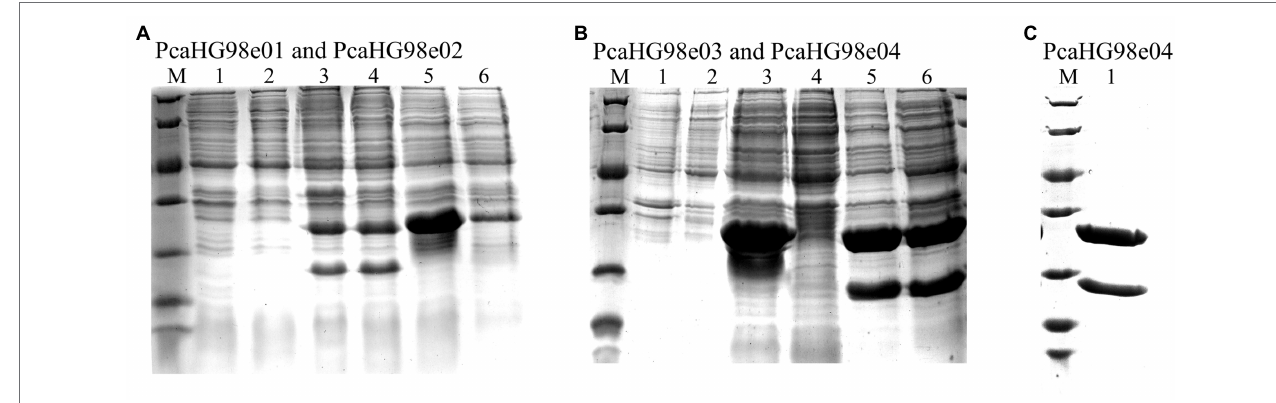
FIGURE 2 | Determination of the expression of recombinant PcaHG in E . coli BL21 (DE3) by SDS-PAGE. Total cell extract and soluble cell extract from induced E . coli BL21 (DE3). Lane M, protein molecular mass standards (Unstained Protein Molecular Weight Marker, No. 26610, Thermo Fisher Scientific, Waltham, MA, United States). (A) lane 1, total BL21 (DE3)/pET-28a (+), lane 2, soluble BL21 (DE3)/pET-28a (+), lane 3, total BL21 (DE3)/pET-28a- pcaHG98e01 , lane 4, soluble BL21 (DE3)/pET-28a- pcaHG98e01 , lane 5, total BL21 (DE3)/pET-28a- pcaHG98e02 , lane 6, soluble BL21 (DE3)/pET-28a- pcaHG98e02 . (B) lane 1, total BL21 (DE3)/pET-28a (+), lane 2, soluble BL21 (DE3)/pET-28a (+), lane 3, total BL21 (DE3)/pET-28a - pcaHG98e03 , lane 4, soluble BL21 (DE3)/pET-28a- pcaHG98e03 , lane 5, total BL21 (DE3)/pET-28a- pcaHG98e04 , lane 6, soluble BL21 (DE3)/pET-28a- pcaHG98e04 . (C) lane 1, soluble BL21 (DE3)/pET-28a- pcaHG98e04 ; lane 2.